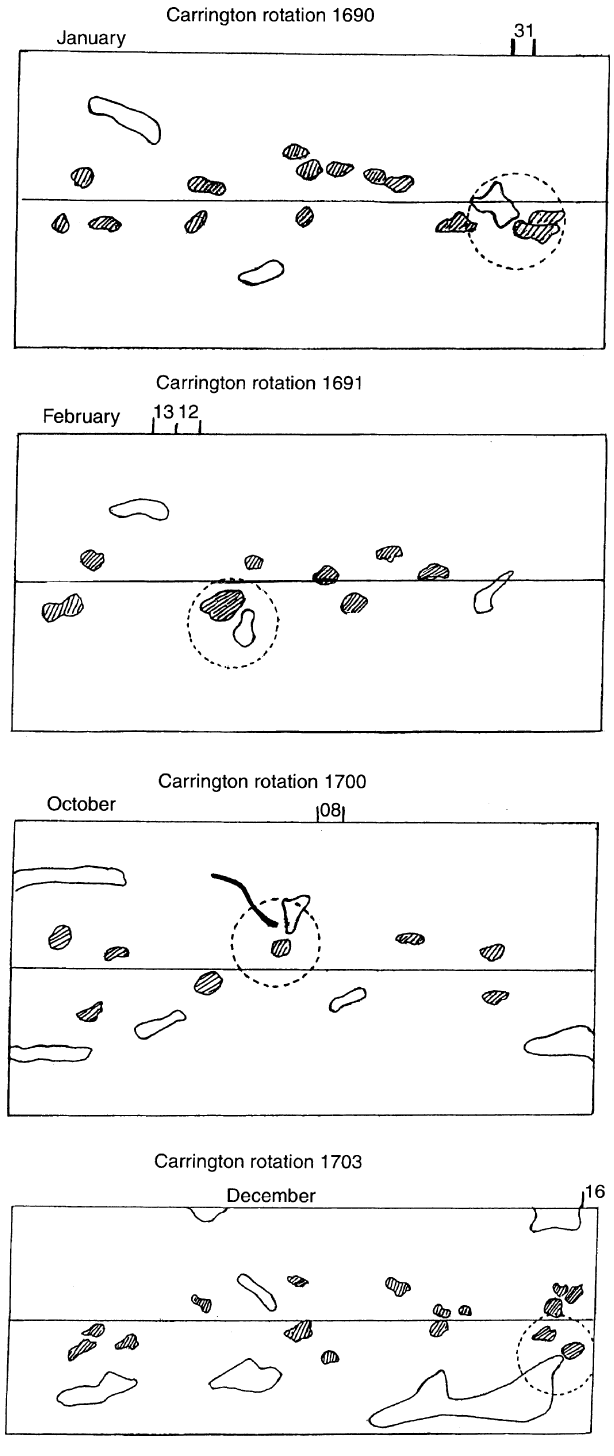
Fig. 6. Carrington rotation maps showing the solar source regions ( circles ) of the interplanetary disturbances that caused four of the 5 IGSs in 1980: January 1, February 16, October 11, and December 19. The position of the solar central meridian at the day of the solar events is indicated at the top of each